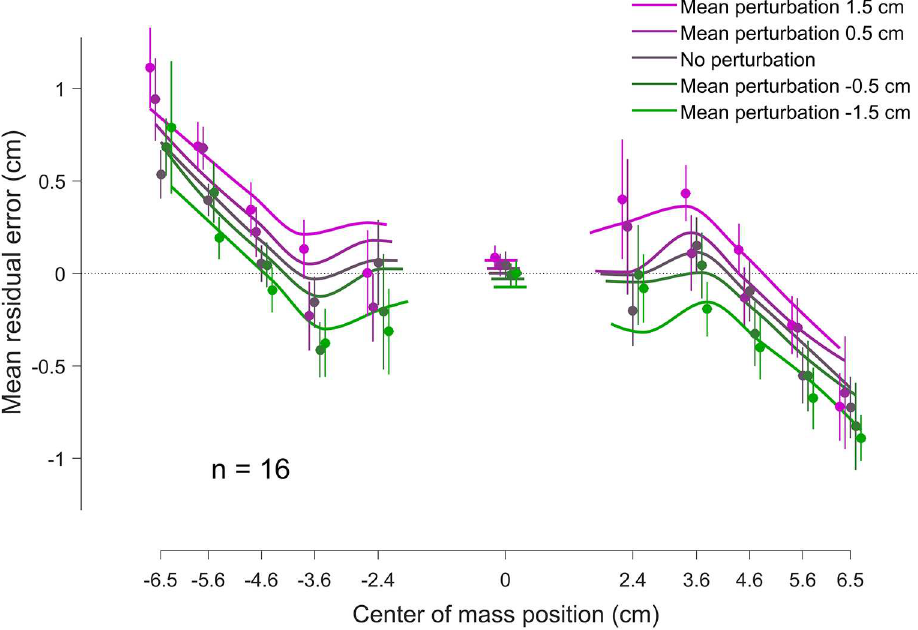
Fig 4. Mean residual error (bias) as a function of the location of the center of mass. Data points and error bars are mean data ± SE across subjects in the test session (binnedfor visualization). Colors correspond to different mean perturbationlevels. Continuous lines are the fits of the Bayesianmodel to each individual dataset, averaged over subjects (asymmetries are due to asymmetries in the data). For both data and model fits, distinct perturbation levels are displayedwith a slight offset on the x axis for visualization purposes. Vertical shifts in residualerror for different levels of perturbationcorrespond to different amounts of averagelack of correction (absoluteresidual errors shown in Fig